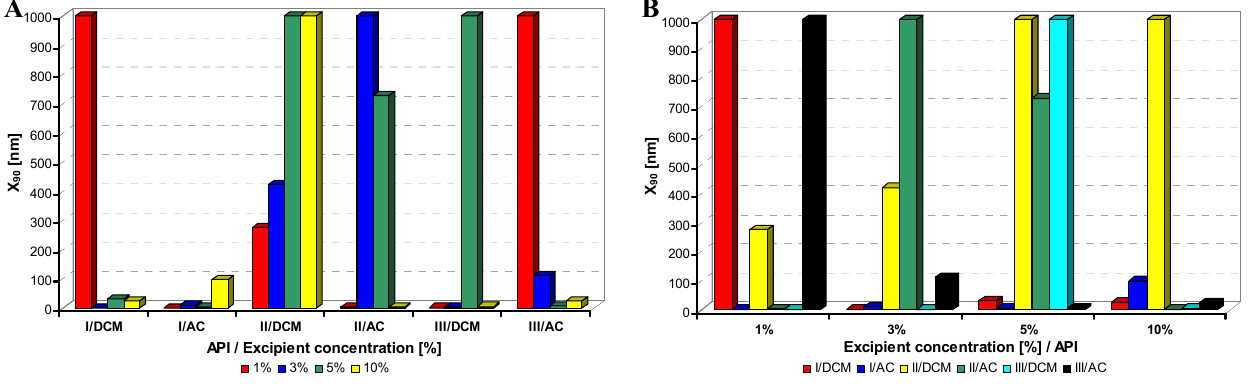
Figure 6. Dependence of particle size (x [nm]) of model APIs I – III on concentration [%] 90 of sodium carboxymethyl dextran in dichloromethane (DCM) or acetone (AC). ( A ) Samples are grouped according to APIs; ( B ) samples are grouped according to excipient percentage. For clarity sake, the values on y-axis are only to 1,000 nm.